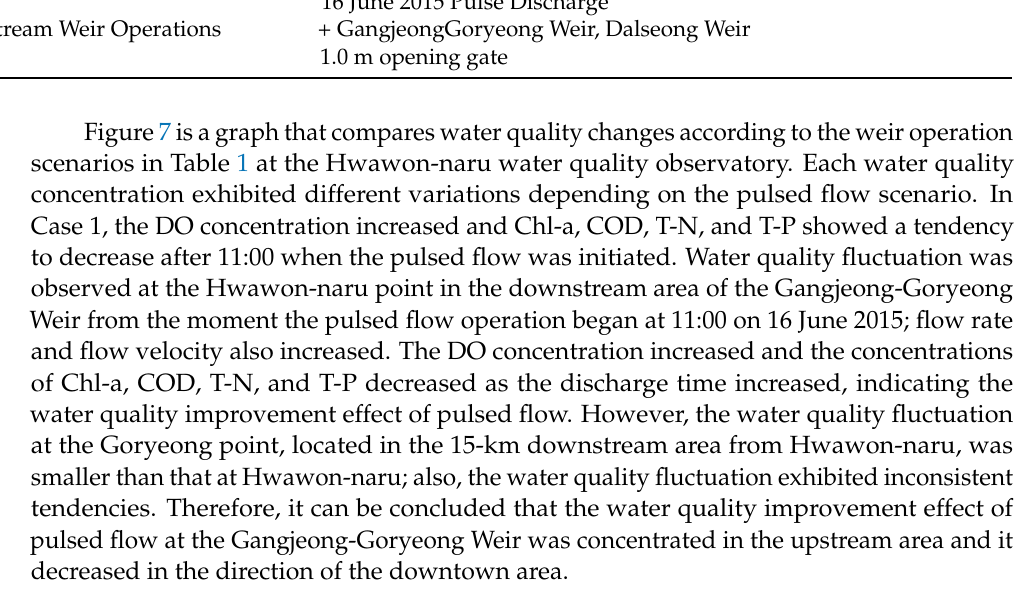
Table 1. Scenario Simulations of the Operating Weir .